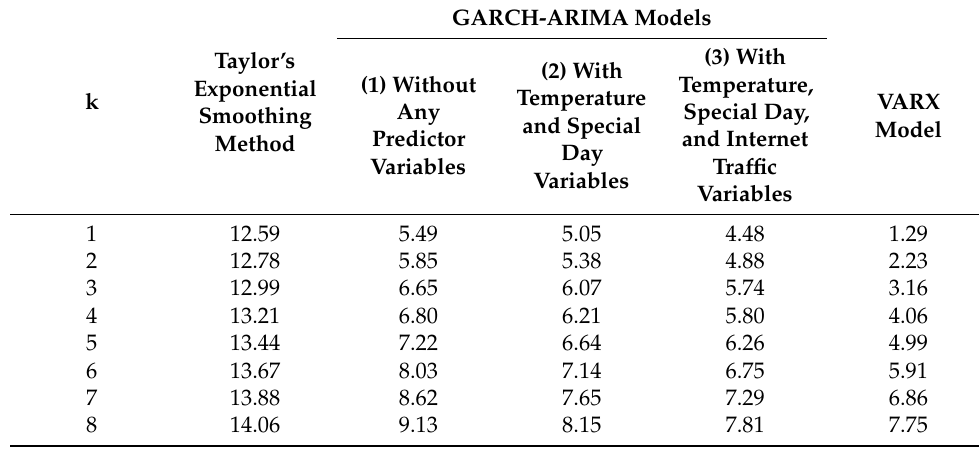
Table 7. Forecast performance evaluation by